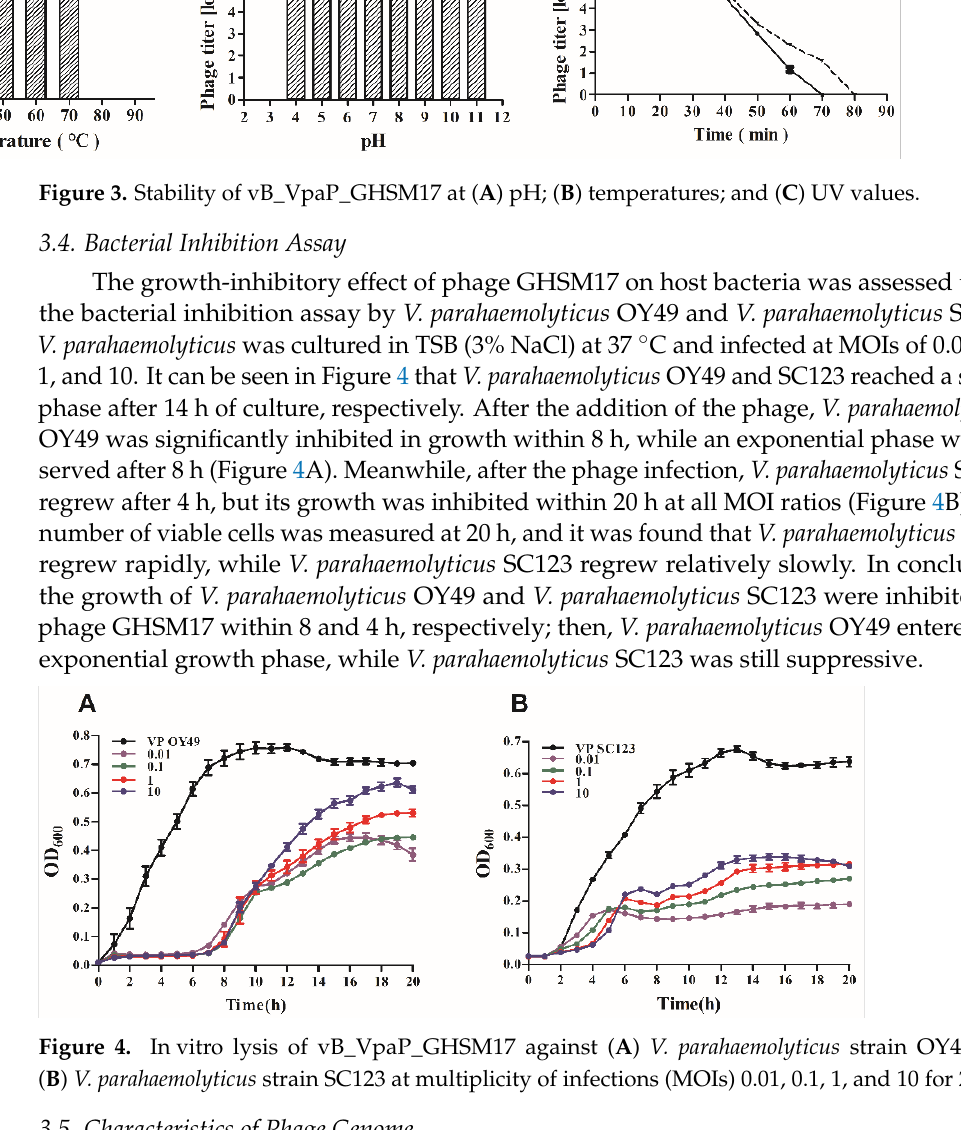
Table 2. Structural characteristics of phage vB_VpaP_GHSM17 genome. Phage